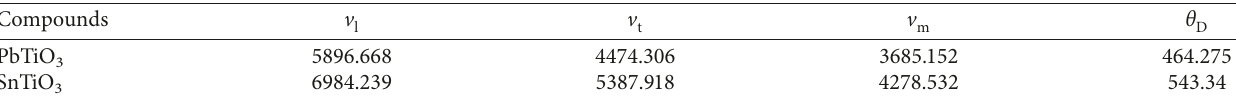
Table 3: Calculated longitudinal, transverse, average sound velocity ( v PbTiO 3.